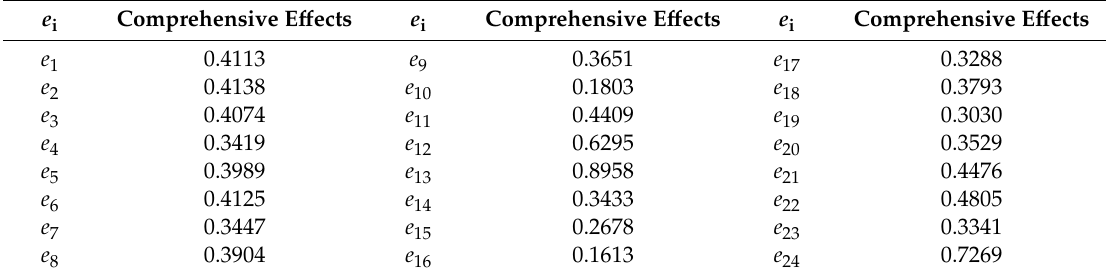
Table 4. Calculation of comprehensive effects of infrared and ultraviolet spectra of 24 QAs based on fuzzy matter-element method.